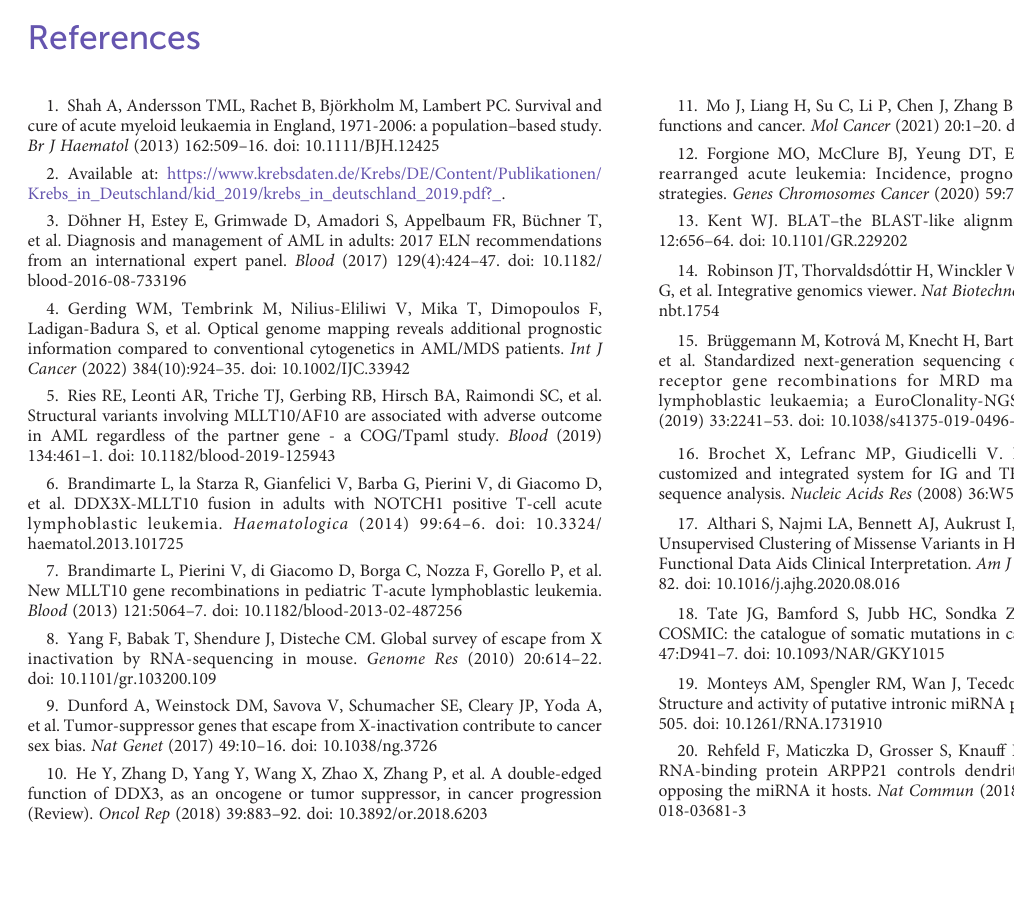
SUPPLEMENTARY FIGURE 1 Immunophenotyping of bone marrow aspirate from the second time point before salvage chemotherapy. Despite a visible neutrophile-cloud compared to initial diagnosis, the blast-population with a similar expression pro fi le is still clearly